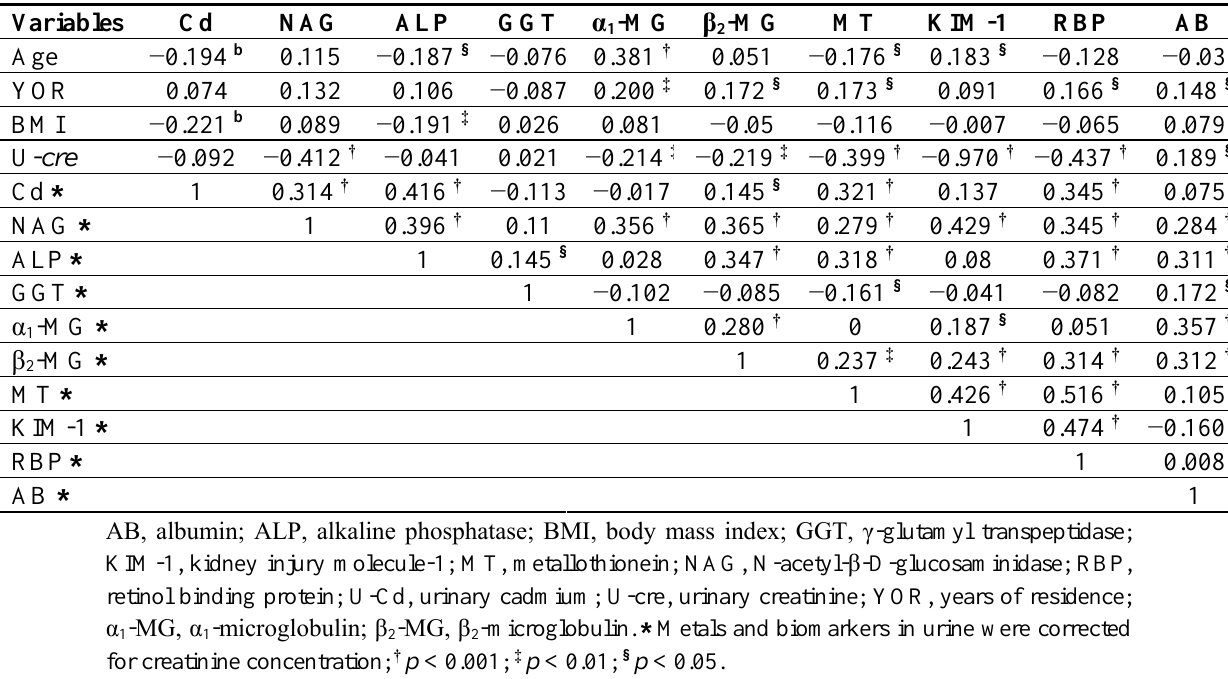
Table 2. Spearman’s rank correlation based on Cr-corrected data.